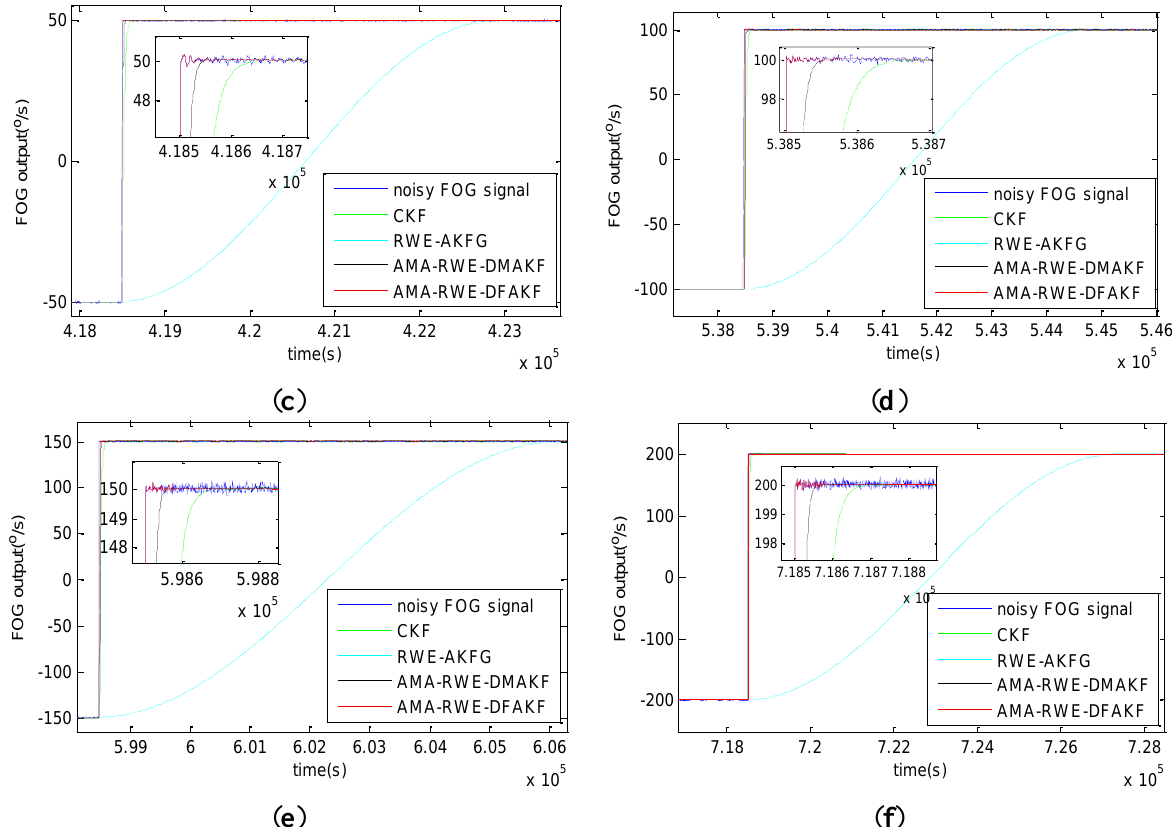
Figure 11. Comparison of denoising results for FOG dynamic signal at different rotations. ( a ) Rotation rate from −2 to 2°/s; ( b ) Rotation rate from −20 to 20°/s; ( c ) Rotation rate from −50 to 50°/s; ( d ) Rotation rate from −100 to 100°/s; ( e ) Rotation rate from −150 to 150°/s; ( f ) Rotation rate from −200 to